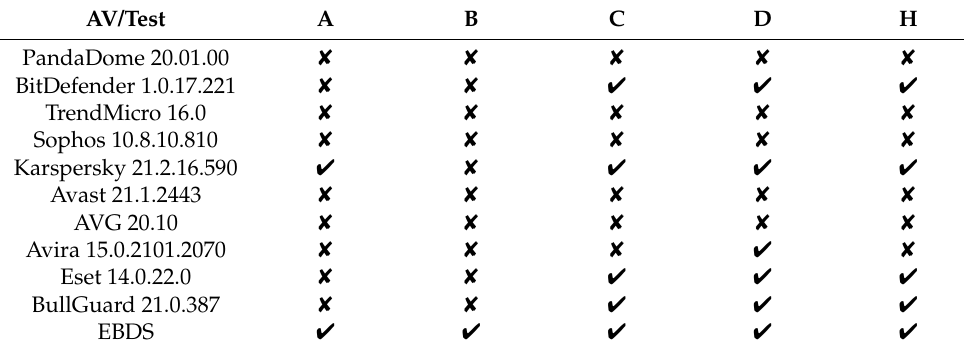
Table 5. Execution of malicious code modified using XOR encryption. AV/Test A B C D H PandaDome 20.01.00 BitDefender 1.0.17.221 TrendMicro 16.0 Sophos 10.8.10.810 Karspersky 21.2.16.590 Avast 21.1.2443 AVG 20.10 Avira 15.0.2101.2070 Eset 14.0.22.0 BullGuard